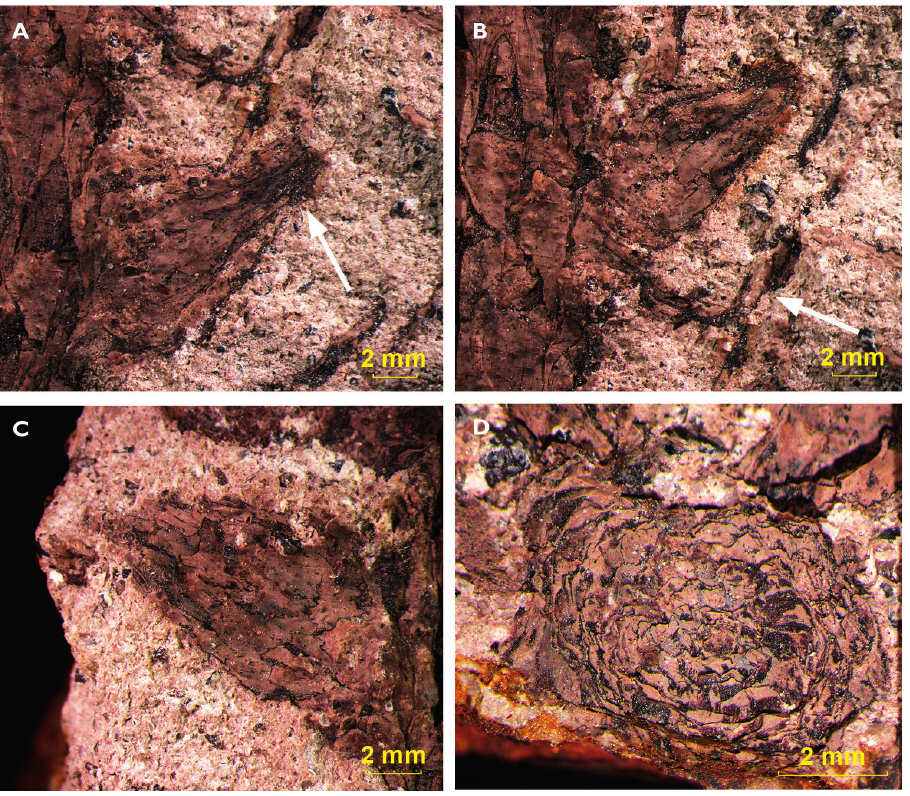
Figure 9. Axillary shoots: A Axillary shoot with apical widening (indicated by arrow), E 06946, Lubná B Axillary shoot with subtending leaf (indicated by arrow), sample E 06946, Lubná C Axillary shoot without broad apical widening, sample E 06950, Lubná D Cross section of axillary shoot, sample E 06946,